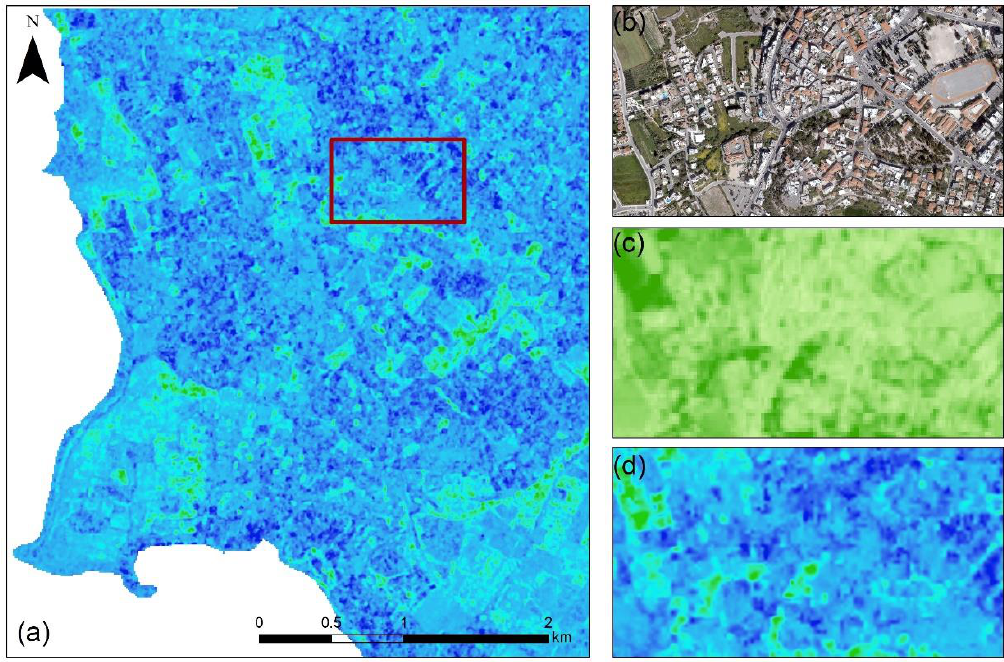
Figure 12. ( a ) Multiplied Radar Vegetation Index (RVI) × Normalized Difference Vegetation Index (NDVI)result. Highervaluesindicatingvegetatedareasareshownwithgreencolour( b )Red-Green-Blue (RGB)orthophotooftheredpolygonof( a )showingthehistoricalCentreofPaphos, ( c )theNDVI—related proportion of vegetation and ( d ) the RVI × NDVI